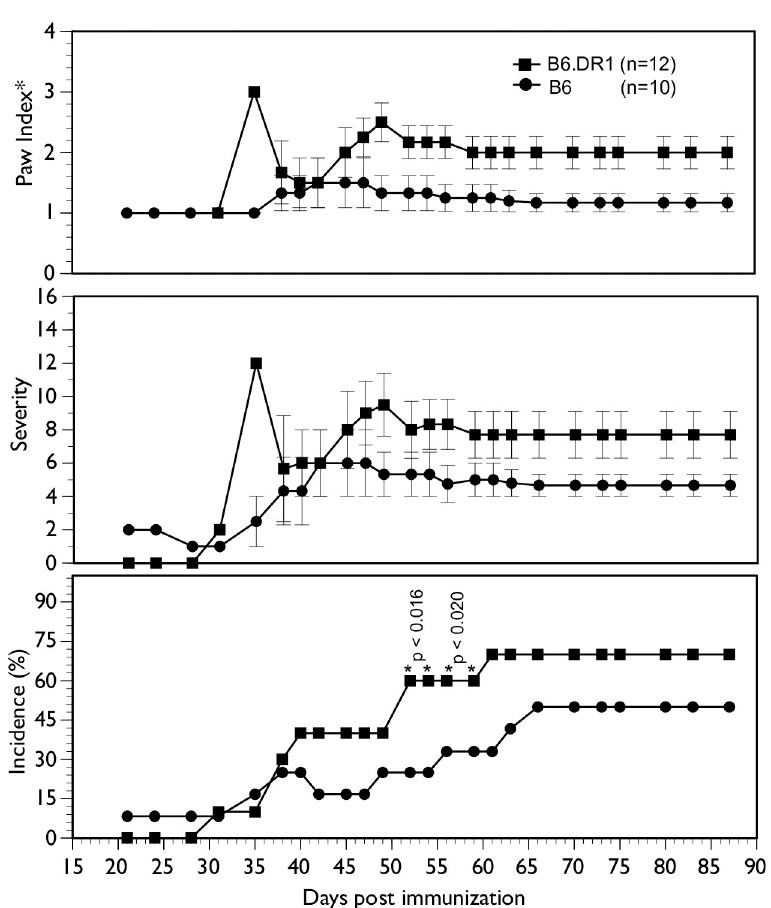
Fig 4. Collagen-induced arthritis is only marginally worse (if at all) in B6.DR1 mice. B6.DR1 or B6 mice were challenged with chicken type II collagen emulsified in CFA as described in the Materials and Methods section. While chi square analyses show statistical differences in the incidence of mid-course arthritis, differences in severity (average score per arthritic mouse) and paw index (average number of arthritic limbs per arthritic mouse) exhibited only slight differences between strains. Stats: chi-square